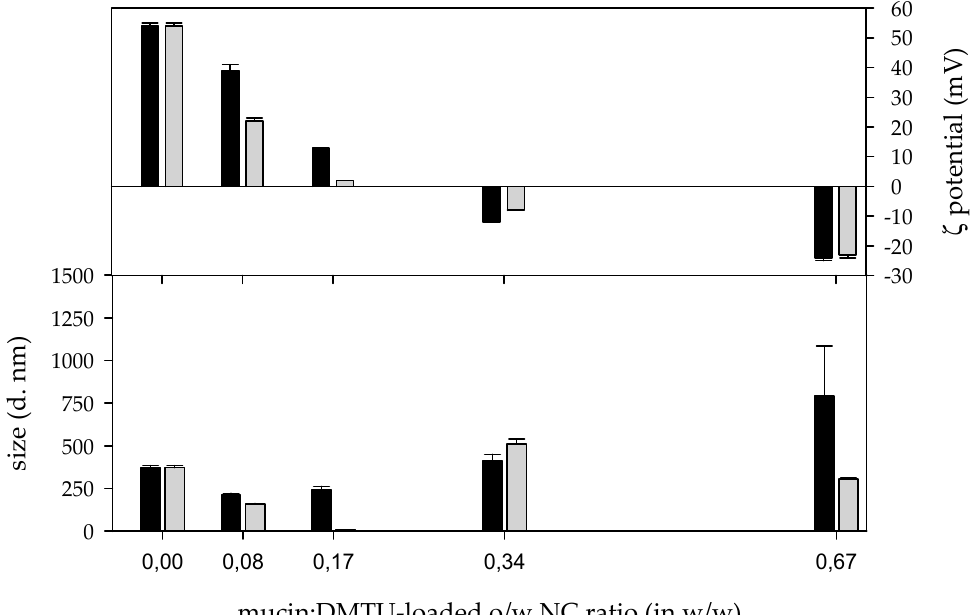
Figure 8. ζ -potential and size (Z-average) of nanocomposites obtained after the interaction among mucin and DMTU-loaded nanocapsules at different ratios at time of synthesis (black) and 24 h (grey) after the preparation event.